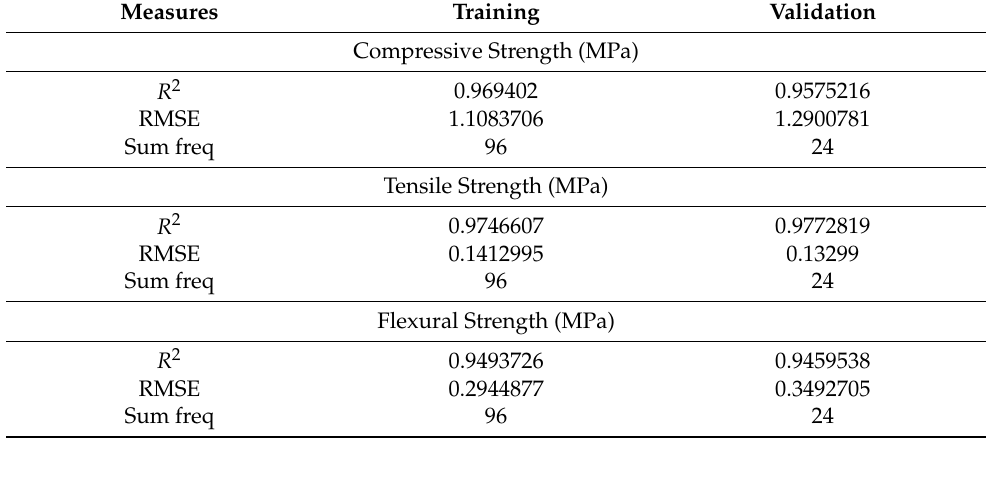
Table 5. Model performance indicators for training and validation procedure.